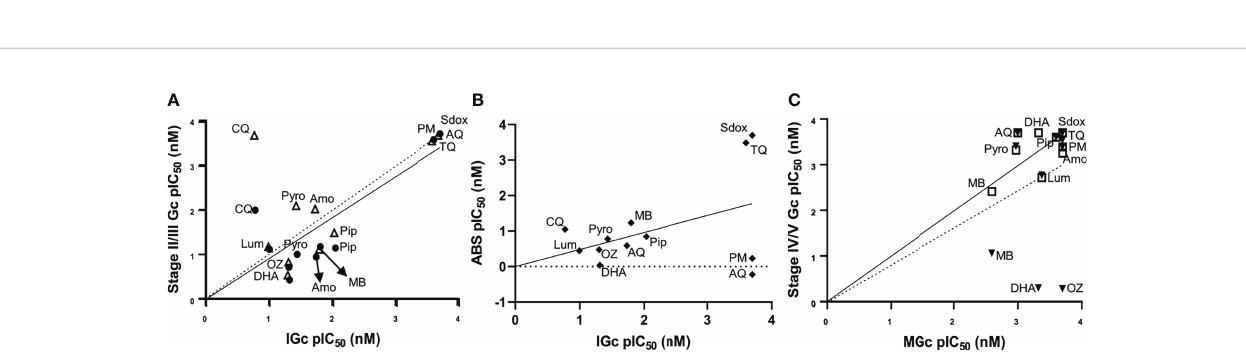
FIGURE 4 | Stage-speci fi c gametocytocidal action evaluation with known antimalarials. Correlation of the gametocytocidal activities of known antimalarials between the luciferase assay on (A) immature gametocytes and data from stage II ( fi lled black circle; solid line) and stage III gametocytes (open triangle; dashed line) from a previous report (Plouffe et al., 2016). (B) Comparison between activity on immature gametocytes and ABS parasites. (C) Mature gametocyte activity compared to stage V (squares; solid line) and stage IV gametocytes ( fi lled black triangles; dashed line) from a previous report (Plouffe et al., 2016). Data are from three independent biological experiments (n = 3), each performed in technical triplicates. DHA, dihydroartemisinin; OZ, artefenomel (OZ439); CQ, chloroquine; Amo, amodiaquine; Pip, piperaquine; Pyro, pyronaridine; Lum, lumefantrine; MB, methylene blue; AQ, atovaquone; PM, pyrimethamine; Sdox, sulfadoxine; TQ, tafenoquine.